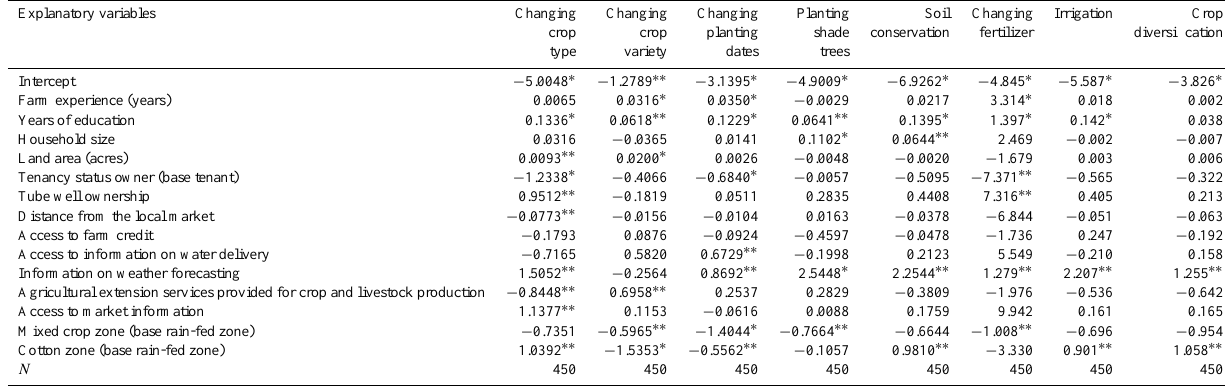
Table 4. Parameter estimates of the logistic regression models of farm-level adaptation measures. Explanatory variables